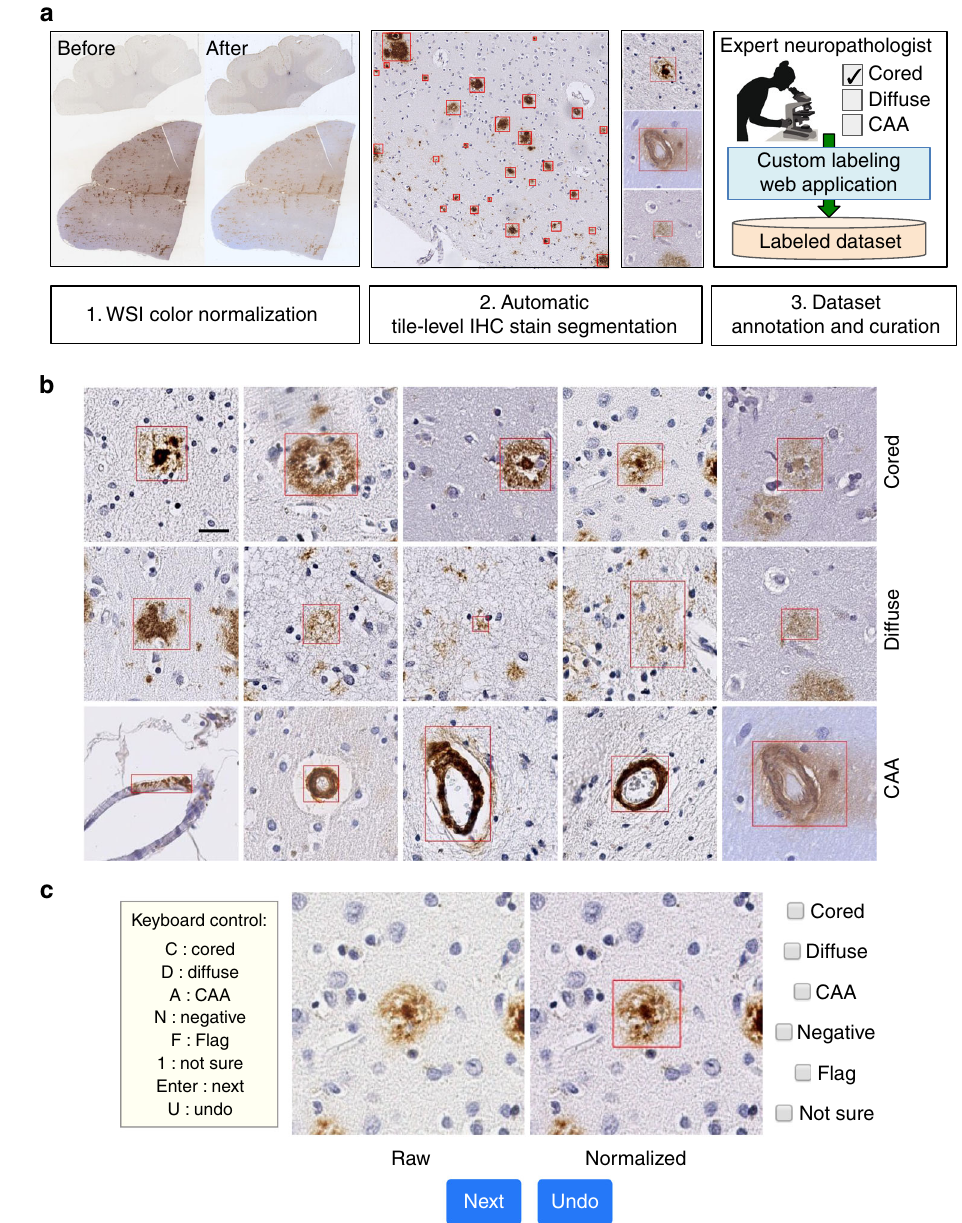
Fig. 2 Creation of an annotated plaque and CAA dataset for machine learning. a Summary of the image processing pipeline, including color normalization, IHC stain segmentation, and extraction of candidate objects (red boxes), followed by rapid expert annotation using a cloud-based web application. b Examples of extracted cored plaques (top row), diffuse plaques (middle), and CAA (bottom) and their surrounding tissue area. Rectangles shown in red bound the candidate object during the labeling process. Scale bar = 25 μ m. c A custom web interface allows for the rapid annotation of plaques by mouse or keystroke, with visualization of raw (without color adjustments) and normalized images, showing the object bounding boxes around which the tile is automatically centered and cropped